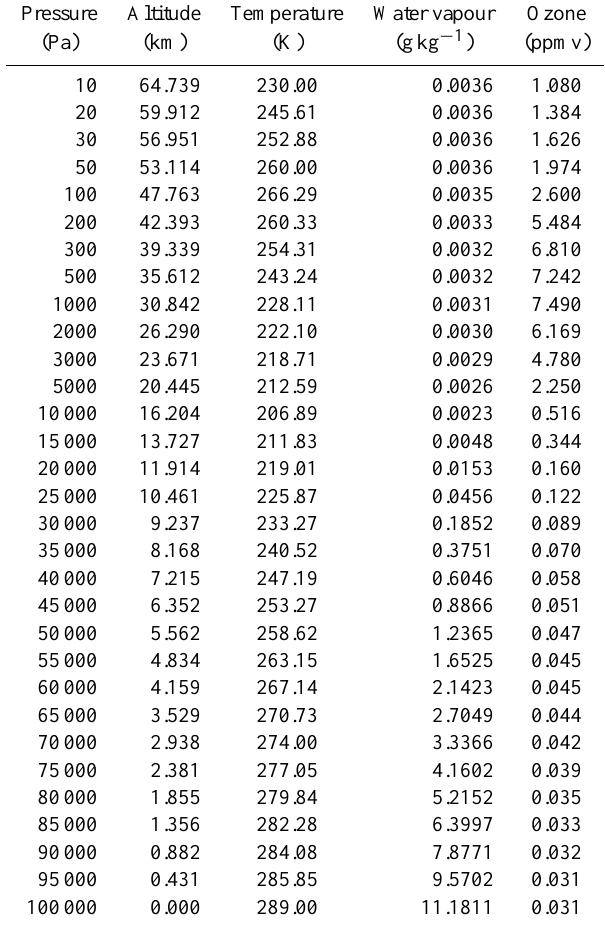
Table 1. GAM profile at levels (layer boundaries). Note that the tropopause is at